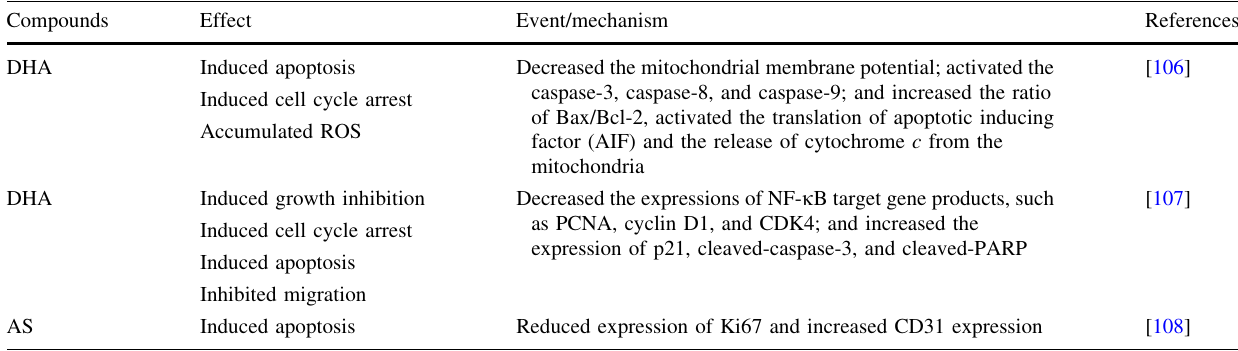
Table 6 Anti-colorectal cancer cells activities of artemisinins